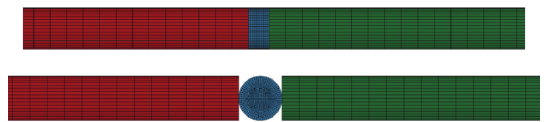
Figure 5: Impact finite element Table 1: Mechanical parameters of rocks in the numerical simulation.